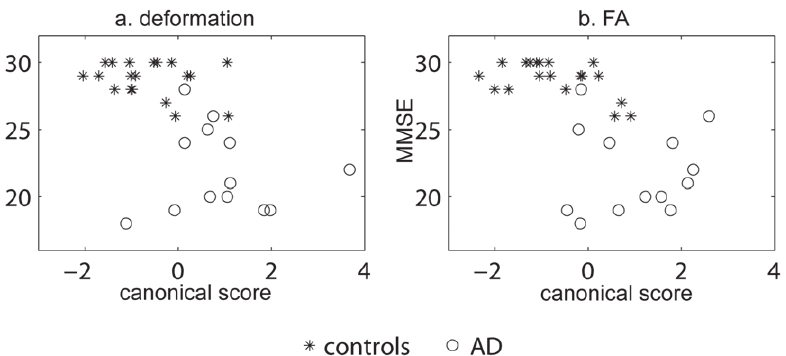
Figure 5. Clinical relations with the shape and FA of the white matter tracts. Panel (a) shows the relation between the MMSE and canonical score of the deformation map, while panel (b) illustrates the relation between the MMSE and canonical score of the FA map. Asterisks and circles respectively denote control and AD subjects.